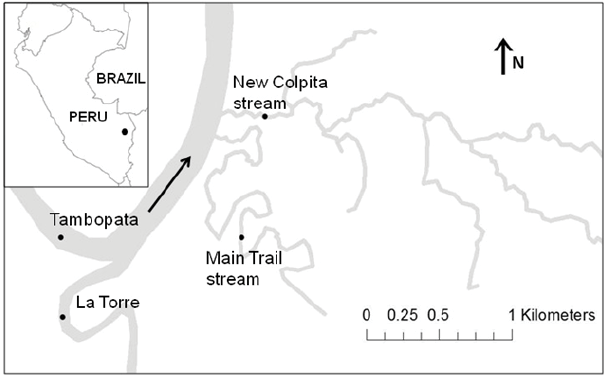
Figure 1. Location of the study area. The circle in the inset map notes the location of the study site, Tambopata National Reserve, Madre de Dios, Peru. In the study area, four independent drainage systems were sampled from 2011 to